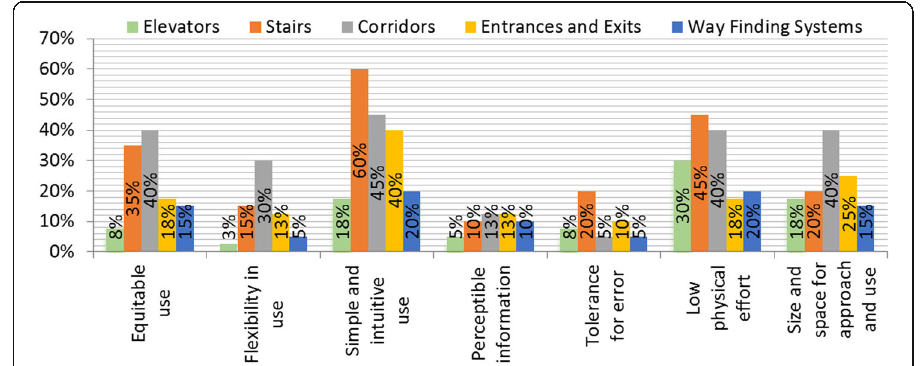
Fig. 28 Compliance of each element with each one of UD principles in building B “ Administrative building of Aswan University